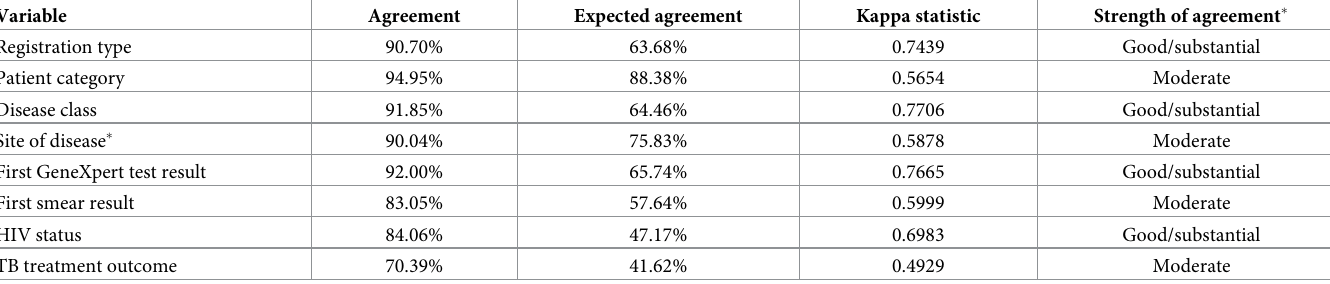
Table 5. Measures of agreement between categorical variables captured in the clinic record and TIER.Net (n = 222).